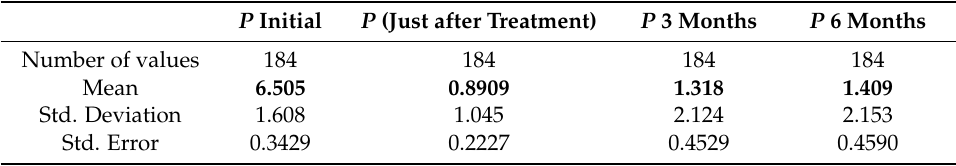
Table 1. Means and standard deviations for pain values before irradiation ( P Initial), immediately after irradiation ( P just after treatment), after 3 months of follow-up ( P 3 months) and after 6 months of follow-up ( P 6